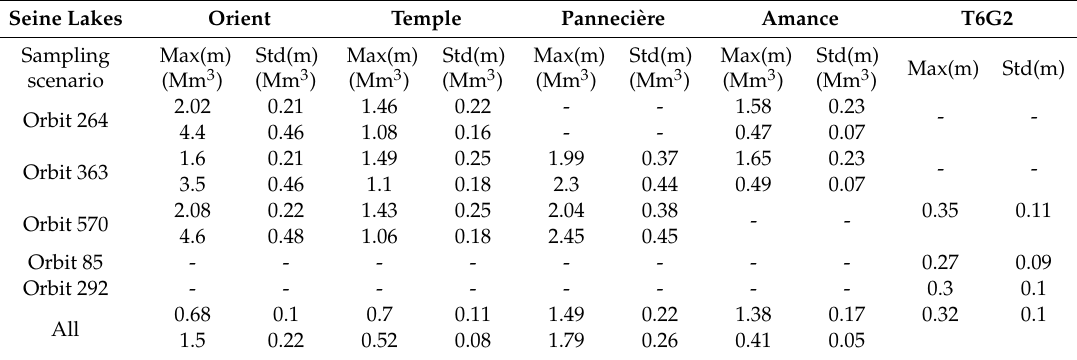
Table 3. Maximal error and standard deviations of the errors on the estimated daily WSE (in meters) for each individual orbit and the maximum sampling scenario (all the orbits). The corresponding water storage errors (in Mm 3 ) were derived for the four gauged reservoirs. Results for the T6G2 gravel pit are also listed.